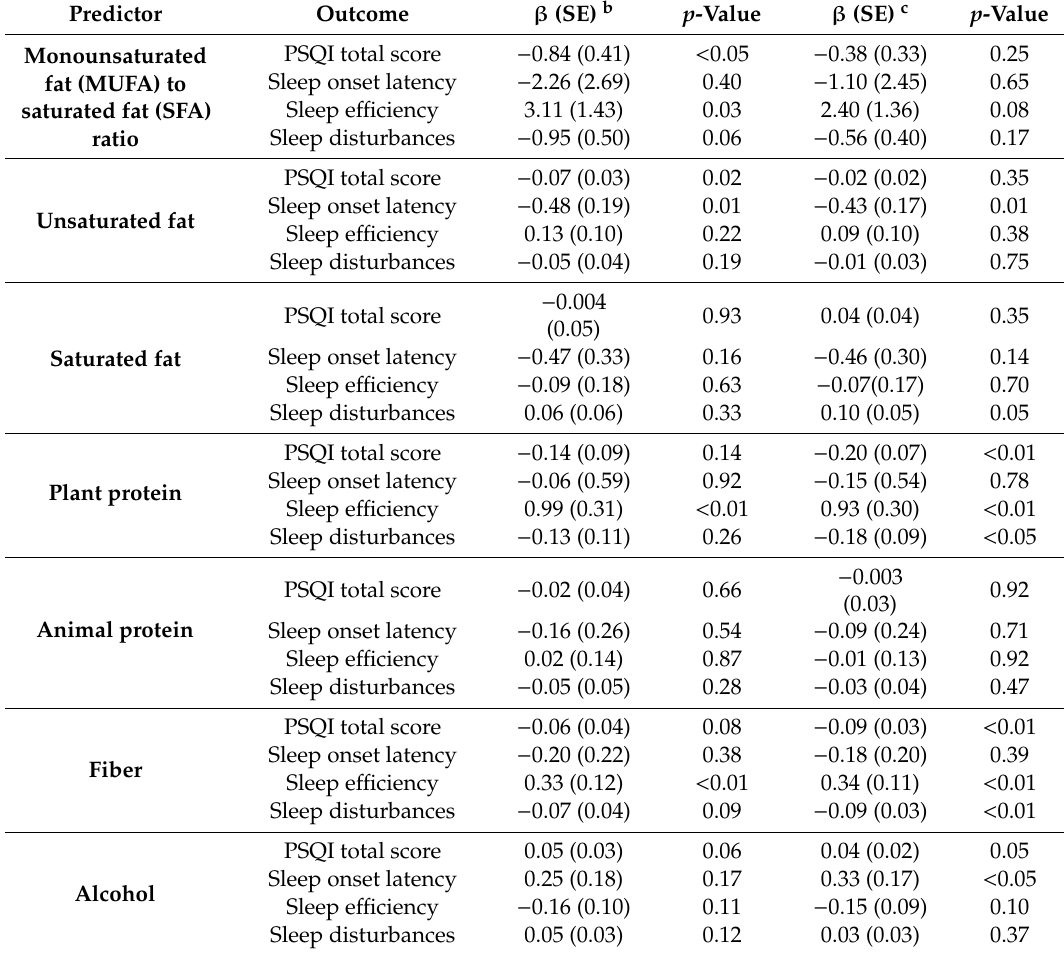
Table 4. Prospective analysis of associations of baseline intakes of major nutrients in food sources in the alternate Mediterranean (aMed) diet with parameters of sleep quality at 1-y follow-up a